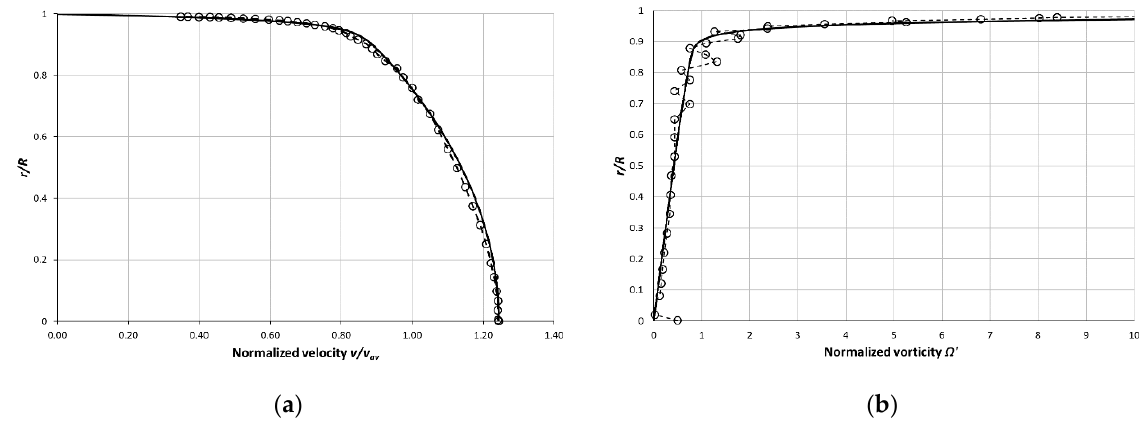
Figure 11. The analytical formula comparison with the experimental data (PSP) for Re = 31,577, using K and N as the variables. Dashed line with circles represents the experimental data, the solid line is the analytical profile. ( a ) Normalized mean velocity profile, ( b ) Normalized vorticity distribution.